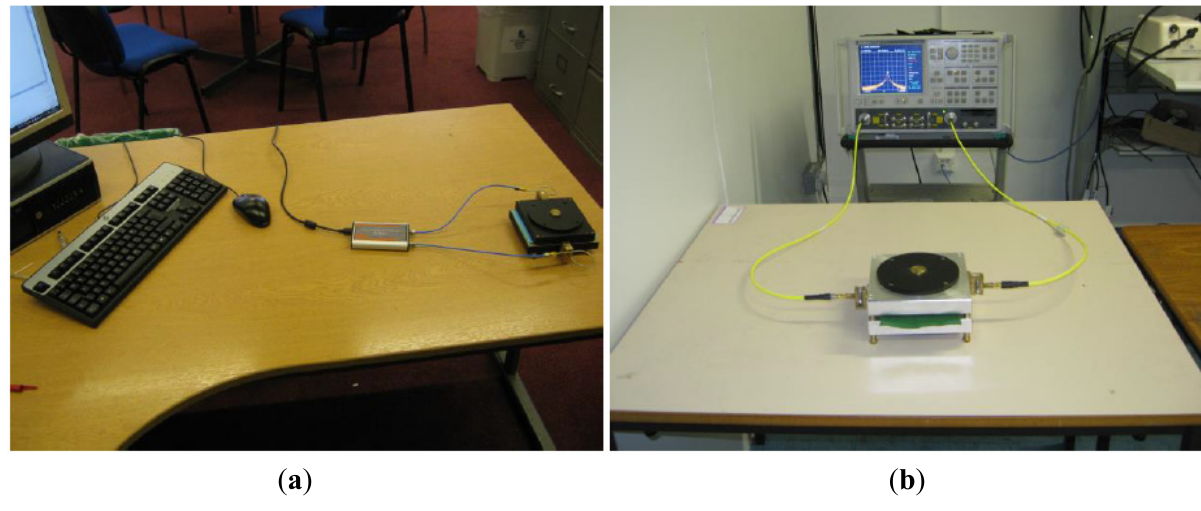
Figure 1. ( a ) Q-meter measurement setup measuring a piece of felt by using the 1.9 GHz split post resonator; ( b ) Resonator-Vector Network Analyzer (VNA) setup measuring a piece of felt by using the 1.1 GHz split post